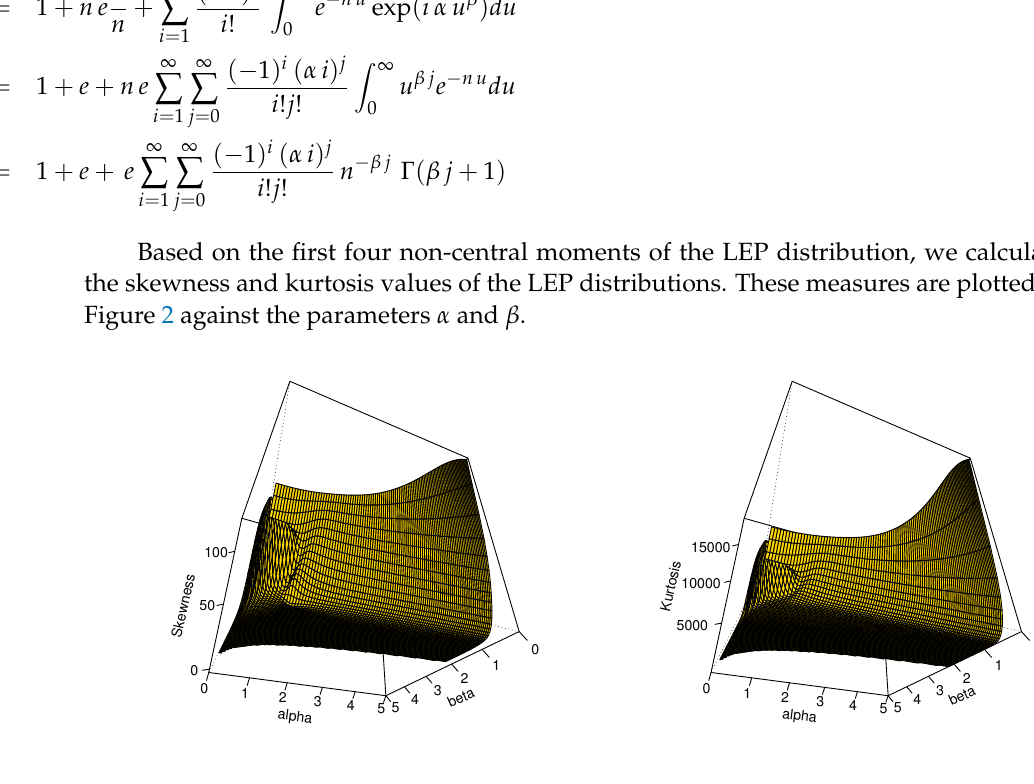
Figure 2. The skewness ( left ) and kurtosis ( right ) plots of LEP